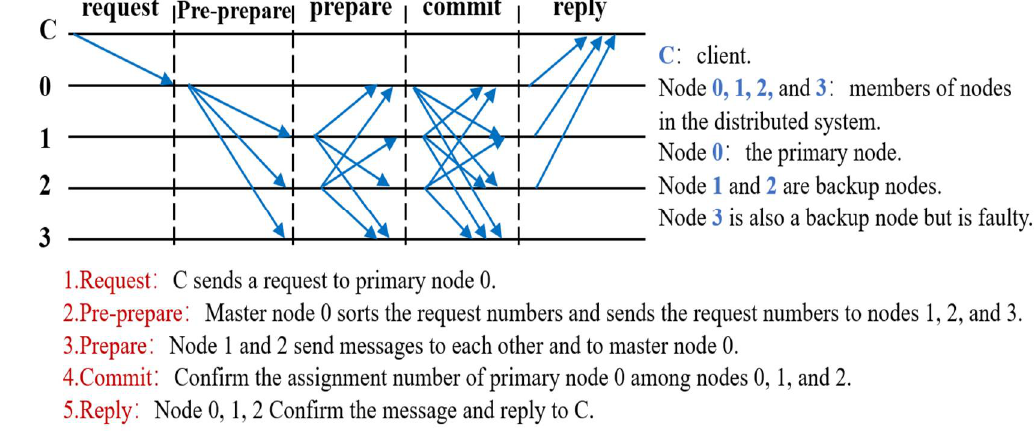
Figure 4. PBFT algorithm flow.